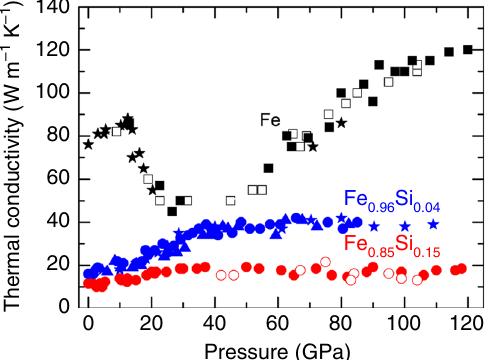
Fig. 1 Thermal conductivity at high pressure and room temperature. The thermal conductivity of powder Fe (black squares) is comparable with that of single-crystal Fe (black stars) and much larger than that of powder Fe 0.96 Si 0.04 (blue symbols) and Fe 0.85 Si 0.15 (red circles), indicating the strong alloying effect of silicon on the thermal conductivity of Fe. Each set of data includes several runs of measurement with solid symbols for compression and open symbols for decompression cycle, respectively. The measurement uncertainties are ≈ 10% before 30 GPa, ≈ 20% at 60 GPa, and ≈ 25% at 120 GPa. The drastic decrease in the thermal conductivity of Fe around 13 GPa results from the bcc – hcp structural transition 30